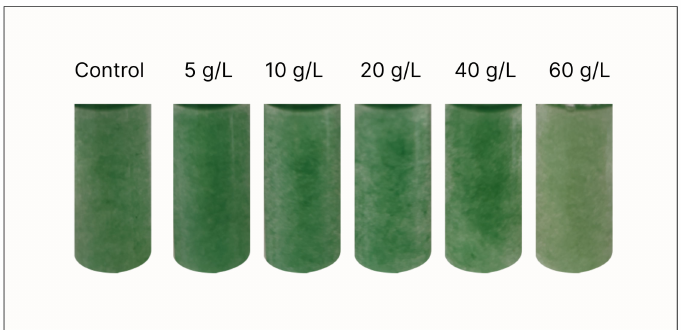
Figure 2. Macroscopic appearance of A. platensis grown at different salinities.